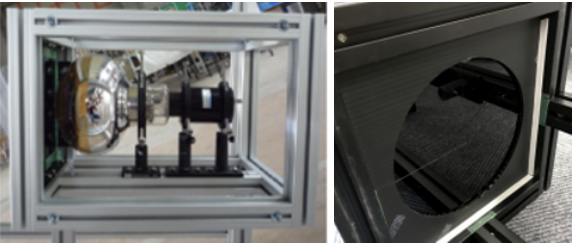
Figure 4. Left: PMT mount. Right: Spacial filter to limit the light with large angles [15].